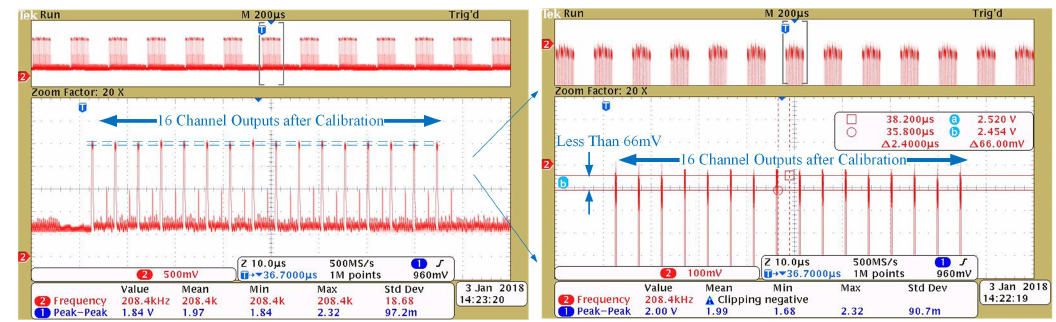
Figure 11. Output voltage variations before and after non-uniformity